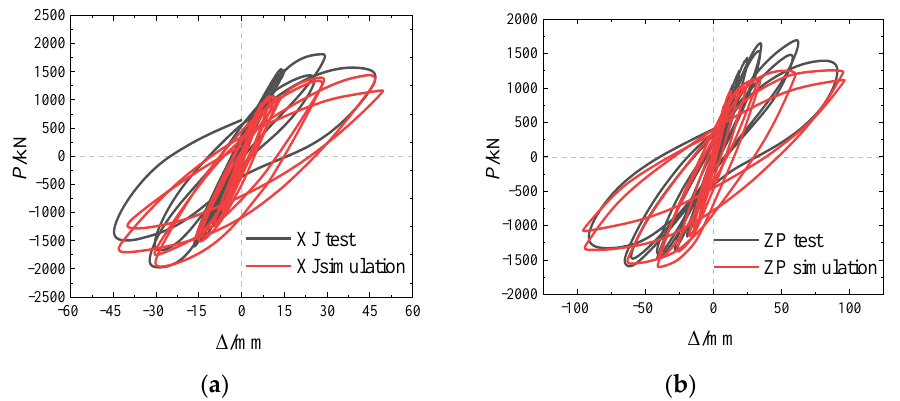
Coatings 2022 , 12 , x FOR PEER REVIEW